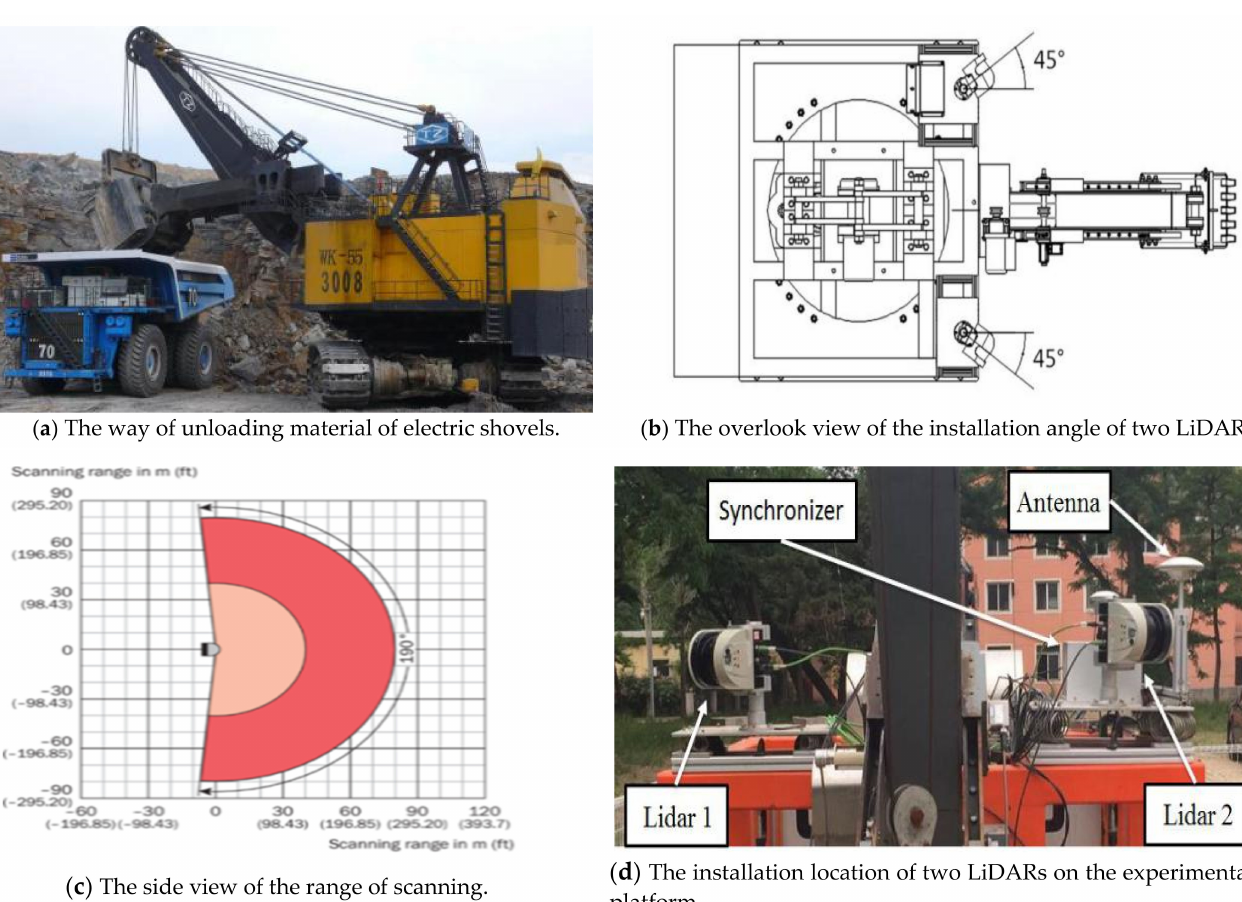
Figure 2. LiDARs installation design principles and physical